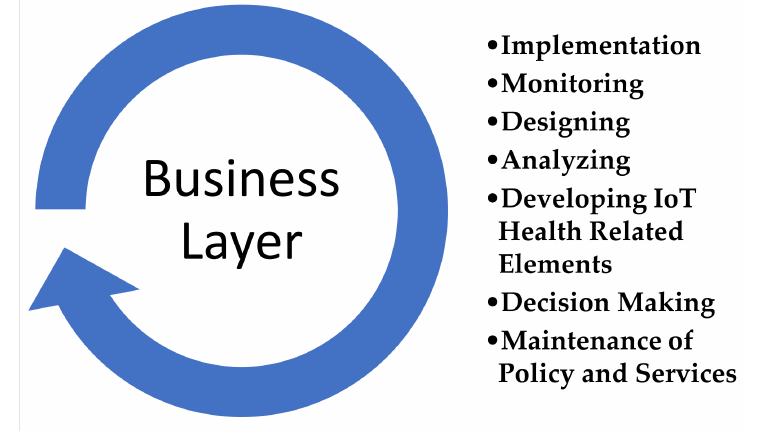
Figure 7. Business